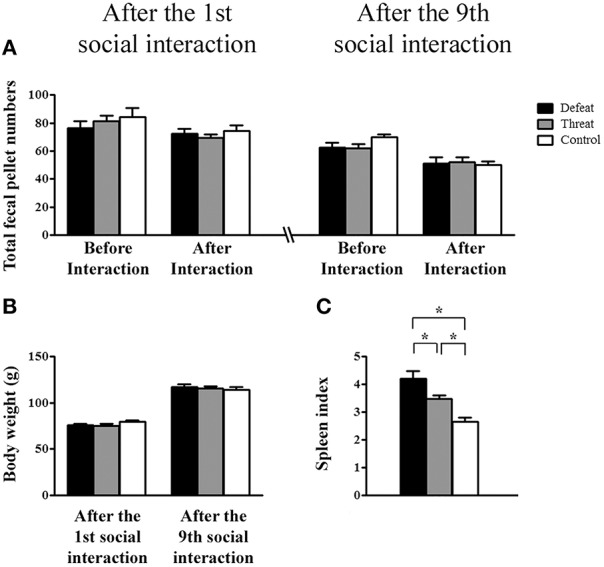
Measurement of the basic physiological changes (means ± SEM) in the three groups (the social defeat group (black bars), the “social threat” group (gray bars), and the arena control group (white bars) after experiencing the 1st (left panels) and the 9th (right panels) social interaction trials across the entire juvenile period in Experiment 2. (A) Total numbers of fecal pellets before and after the indicated social interaction trial in Experiment 2a (batch #1, n = 12 per group). (B) Body weight (g) after experiencing the 1st and 9th social interaction trials in Experiment 2a. (C) The spleen index [i.e., spleen mass (mg)/body weight (g)] after experiencing nine social interaction trials in Experiment 2b (batch #2, n = 8 per group). *p < 0.05.